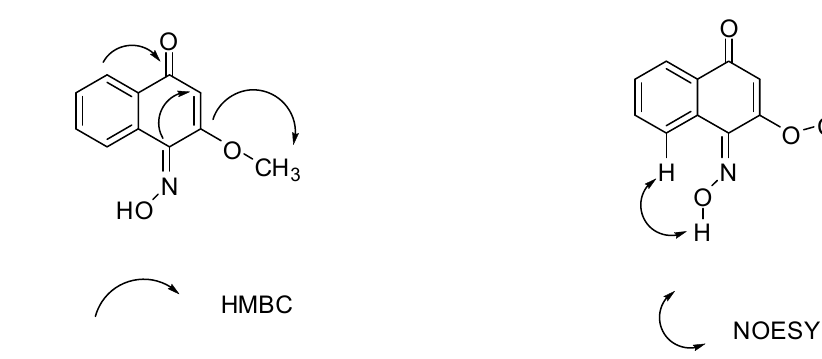
Figure 2. Key HMBC and NOESYof compound Z-4-2 .